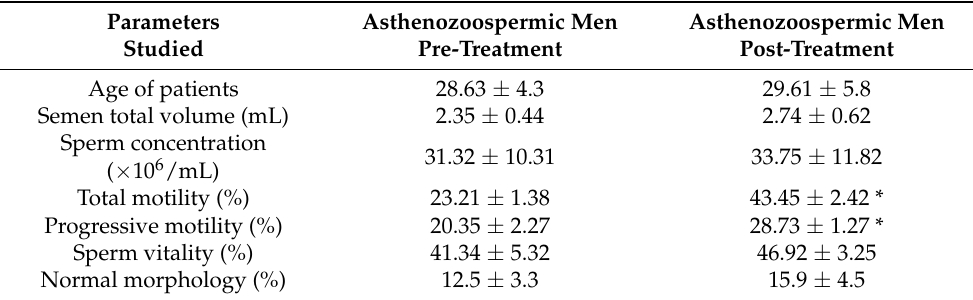
Table 2. Parameters evaluated in asthenozoospermic patients ( n = 20), pre-treatment and post- treatment; *: p <